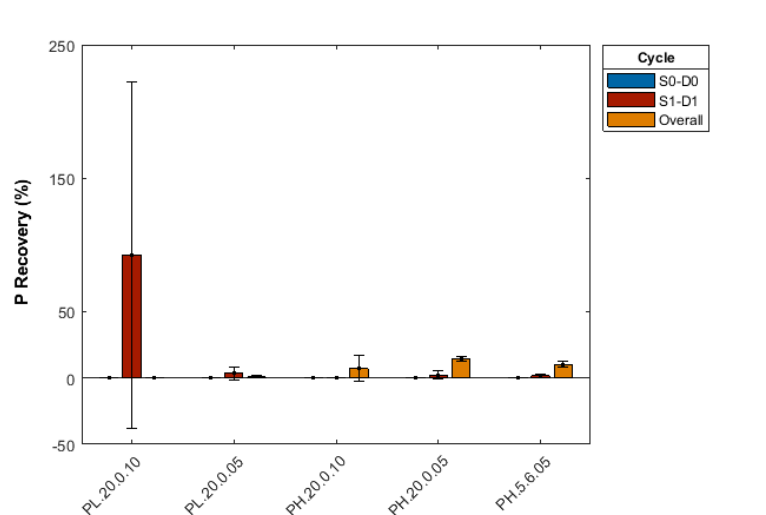
Figure 10. Phosphorus (P) recovery across all evaluated cycles and treatments for PhosRedeem. The treatments identified on the x-axis follow the notation: PX.PV.RC.RT, with X being the level of P concentration (L for low or 0.5 mg L − 1 and H for high or 50 mg L − 1 ), PV: pore volume (5 or 20), RC: number of recirculations (0, 6, or 24) and RT: residence time used in the desorption